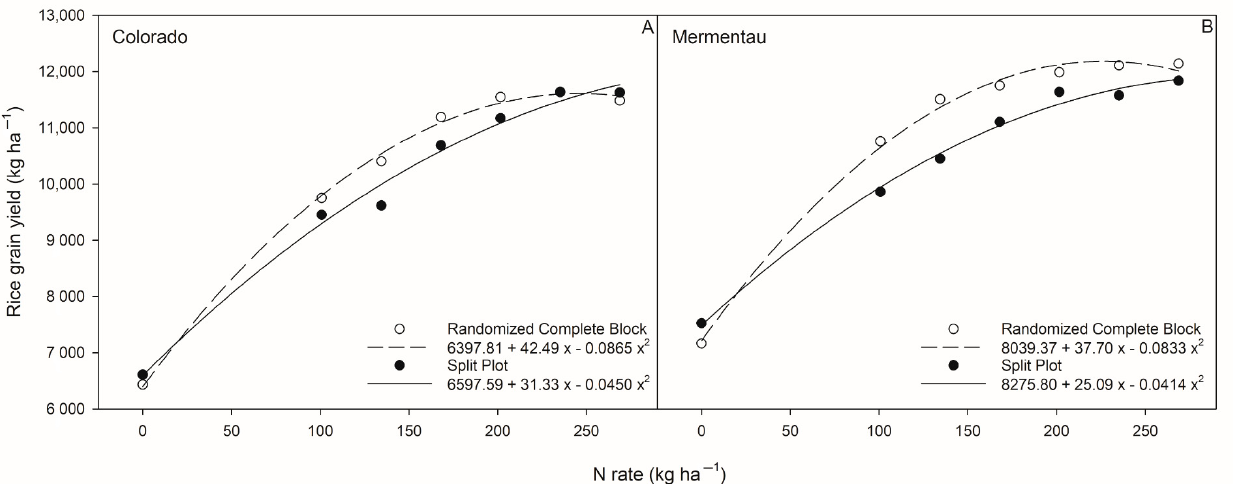
Figure 2. Rice grain yield response of two cultivars, Colorado ( A ) and Mermentau ( B ), to N fertilizer rates for an experiment comparing the trend of a randomized complete block design to the trend of a split-plot experimental design for environments with clay textured soil in 2013 and 2014.